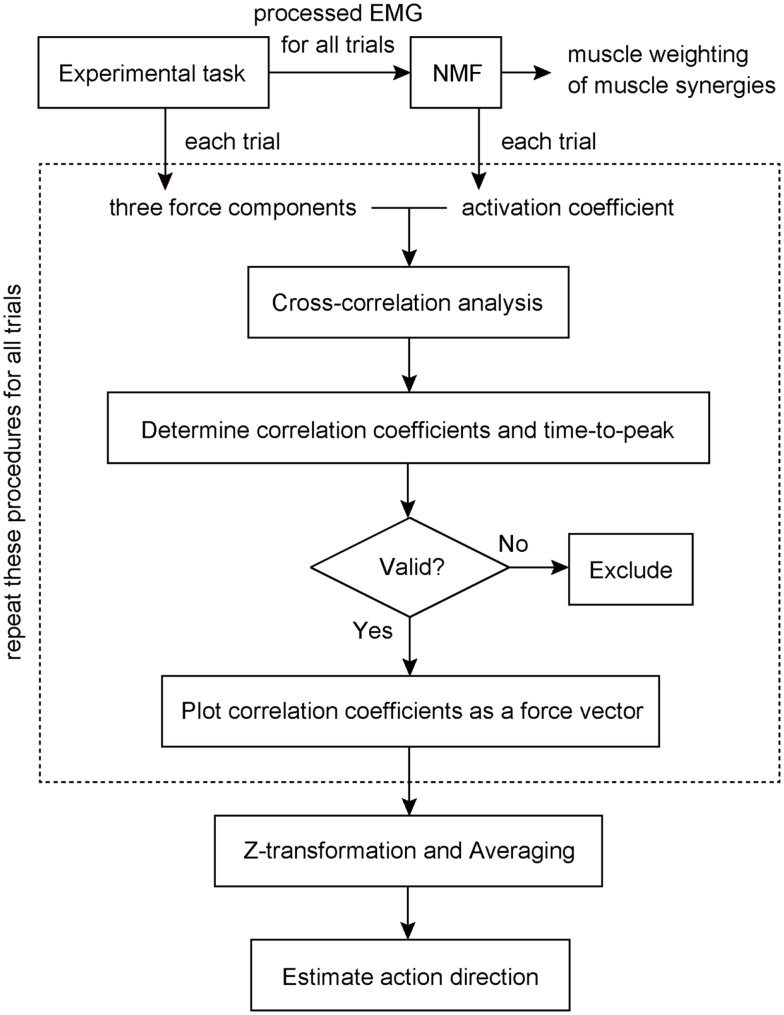
Block diagram to estimate action direction of a muscle synergy. Muscle weightings and activation coefficients of muscle synergies were first extracted from processed electromyogram (EMG) data for all trials using non-negative matrix factorization (NMF). The cross-correlation analysis was then performed between the traces of three force components and activation coefficient of a muscle synergy recorded and estimated in each trial to determine each correlation coefficient and the time-to-peak. If the correlation was physiologically valid, the correlation vector was plotted in three-dimensional space as a force vector. These procedures (surrounded by a dashed line) were repeated for all trials. Finally, we estimated the action direction of the muscle synergy, which was the averaging of force vectors after the correlation coefficients underlying the force vector were transformed with Fisher’s Z transformation. The details were described in the Section “Materials and Methods.”